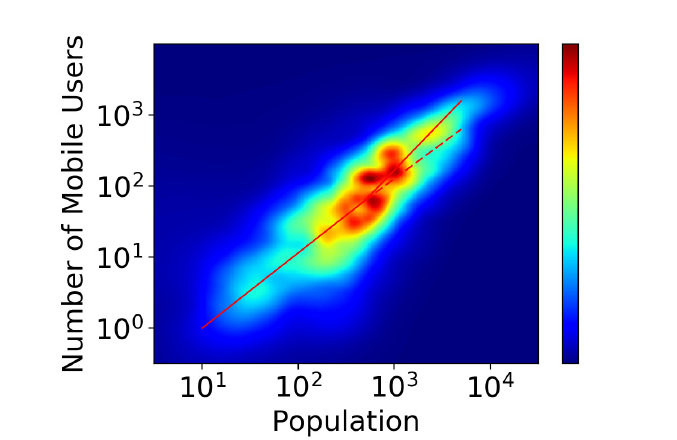
Figure 1. The linear correlation between log-scale mobile phone users and log-scale